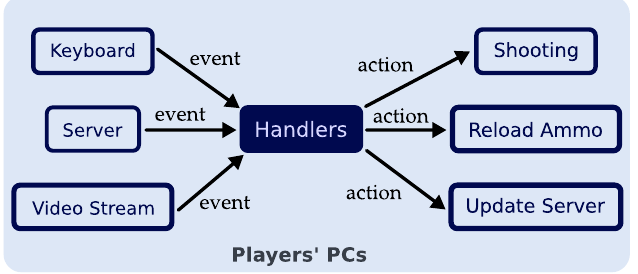
Fig. 3. The game is based on events that are passed to handler functions in charge of executing the different actions.